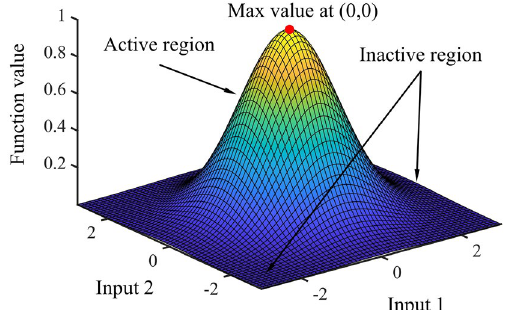
Figure 11 The image of the Gaussian function (the input dimension is